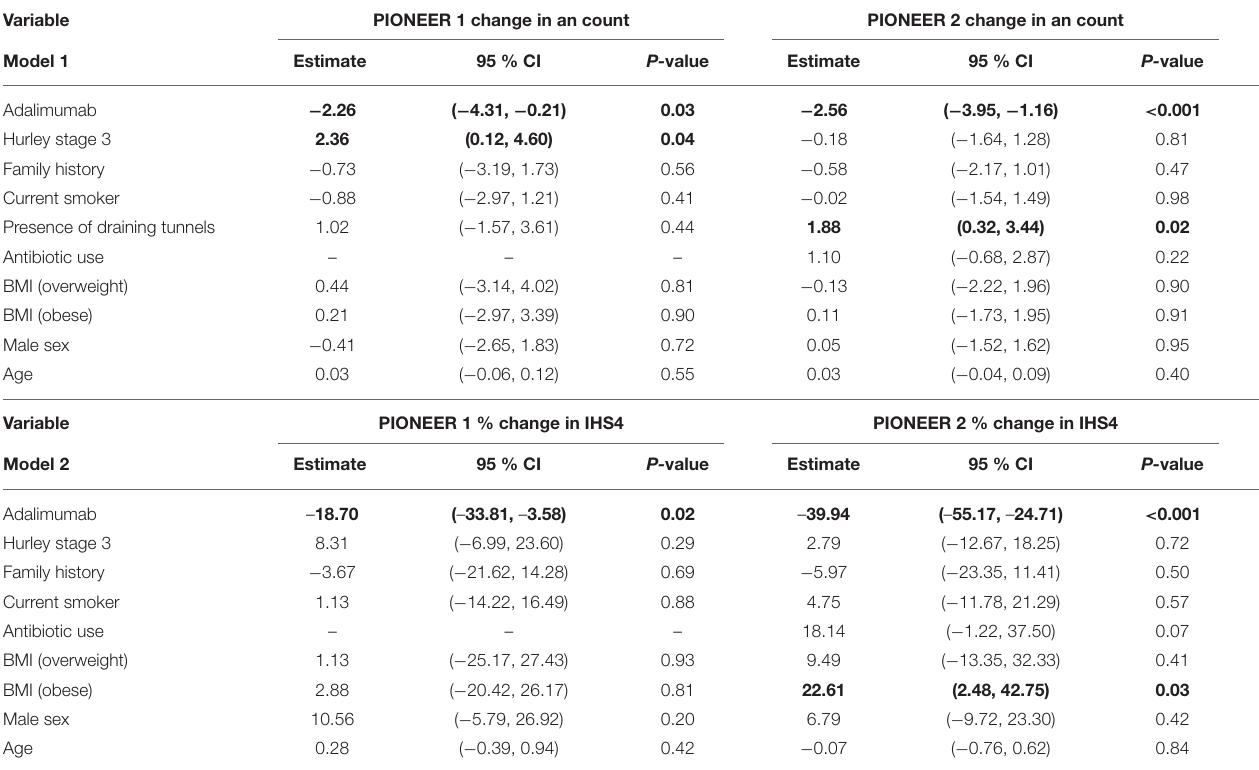
TABLE 4 | Linear regression model of change in AN count (Model 1) and % change in IHS4 outcome measure in (Model 2) in Adalimumab treated patients in PIONEER 1 and PIONEER 2. Variable PIONEER 1 change in an count PIONEER 2 change in an